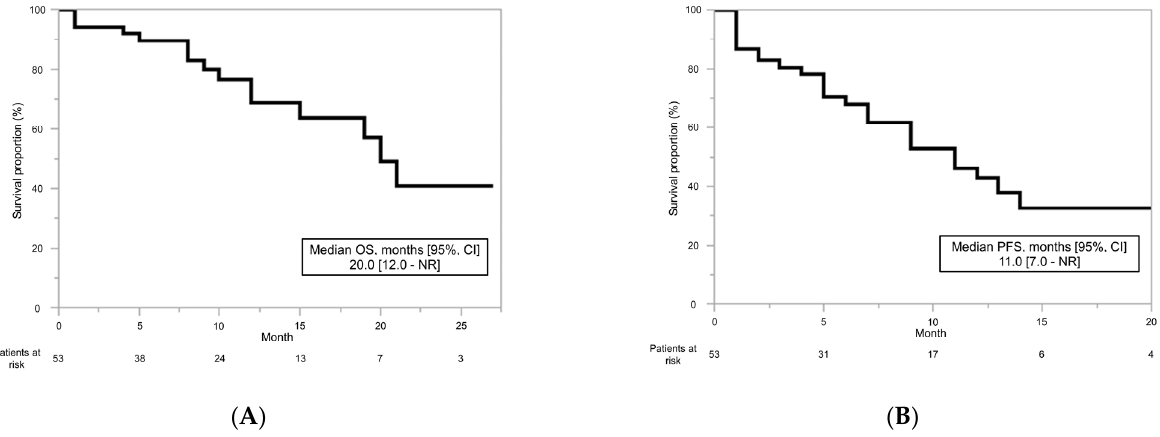
Figure 1. Overall survival (OS) and progression-free survival (PFS) for cabozantinib in patients with advanced or metastatic renal cell carcinoma. The median OS was 20.0 months ( A ). The median PFS was 11.0 months ( B ). Table 2. Treatment effect in patients who received